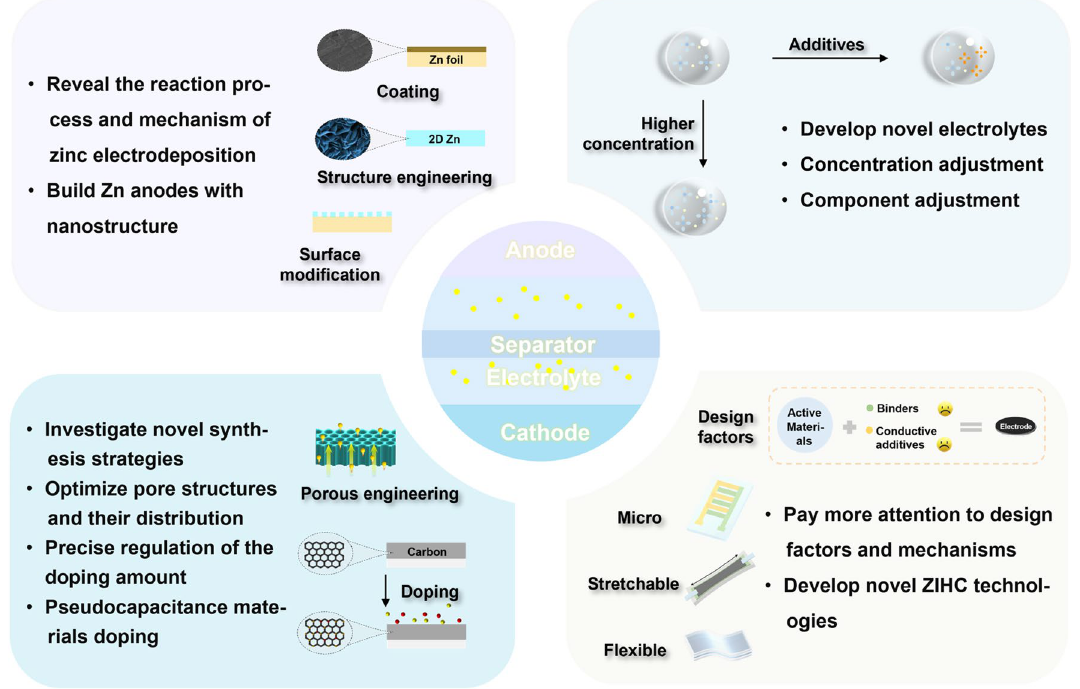
Fig. 15 Design strategies and perspectives of Zn anodes, carbon-based cathodes, electrolytes, and ZIHC